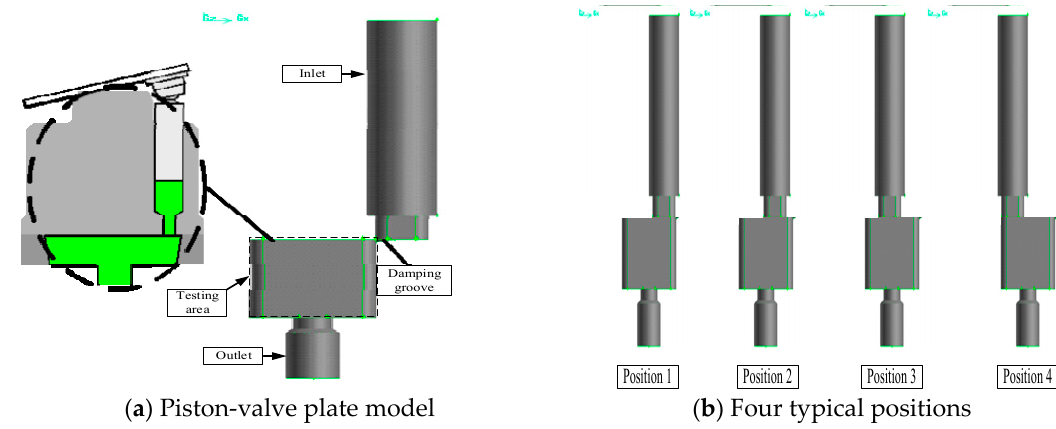
Figure 3. Piston-valve plate model.